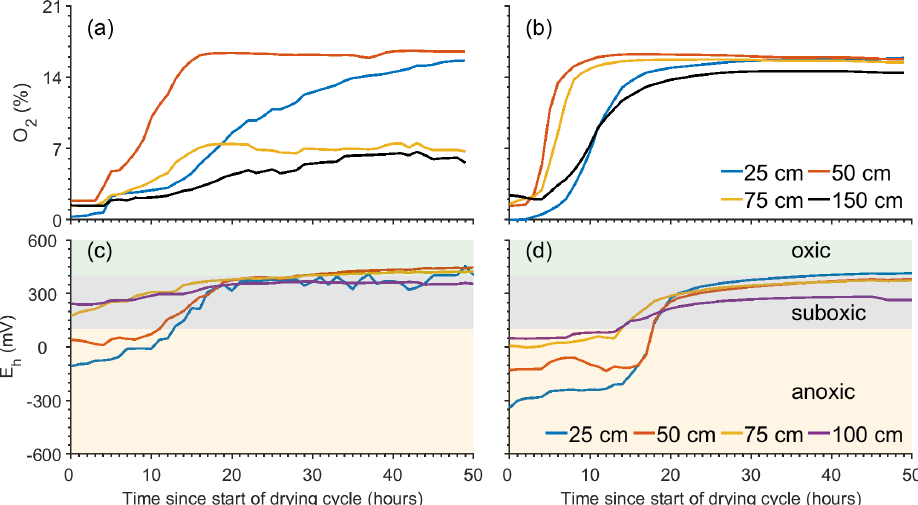
Figure 9. Plot of hourly means of E h and gaseous O 2 measurements from the beginning of the drying stages. The statistics are based on (a, c) 14 cycles during winter (November–April) and (b, d) 19 cycles during summer (May–October). Note that the gaseous O 2 (a, b) measurements were obtained at 25, 50, 75, and 150cm depths, and the E h conditions (c, d) were observed at 25, 50, 75, and 100cm depths. All observations were conducted in station 2. The data are separated between summer and winter according to the trends presented in Fig. 5. The green, grey, and yellow areas represent the oxic (400mV < ), suboxic (400mV >E h > 100mV), and anoxic E h < 100mV) conditions,